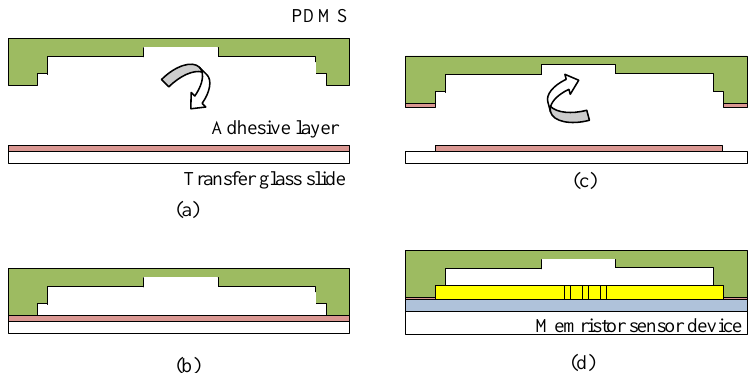
Figure5. GraphicalviewofPDMSattachmentprocessusingadhesivebondingtechnique( a )Uniformadhesive Figure 5. Graphical view of PDMS attachment process using adhesive bonding technique ( a ) Uniform layerontransferglass; ( b )adhesionprocess; ( c )liftoffwithadhesivelayeratbondingcontactpoint; ( d )bonding adhesive layer on transfer glass; ( b ) adhesion process; ( c ) lift off with adhesive layer at bonding process (PDMS chamber attached on sensing contact point; ( d ) bonding process (PDMS chamber attached on sensing platform).